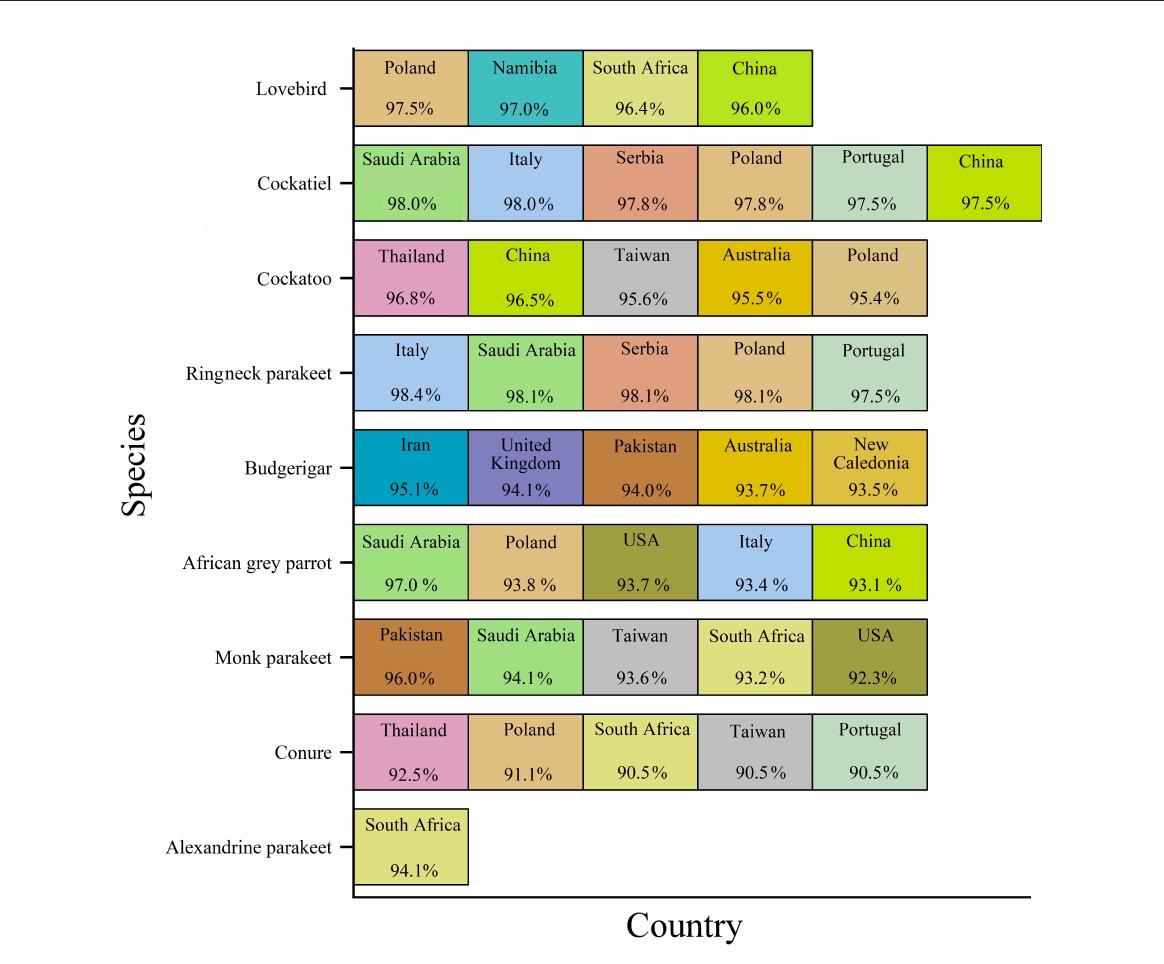
FIGURE2 GenBank-published BFDV sequences from different countries and species. Countries were arranged from left to right based on percentage of similarity, with the leftmost showing the greatest